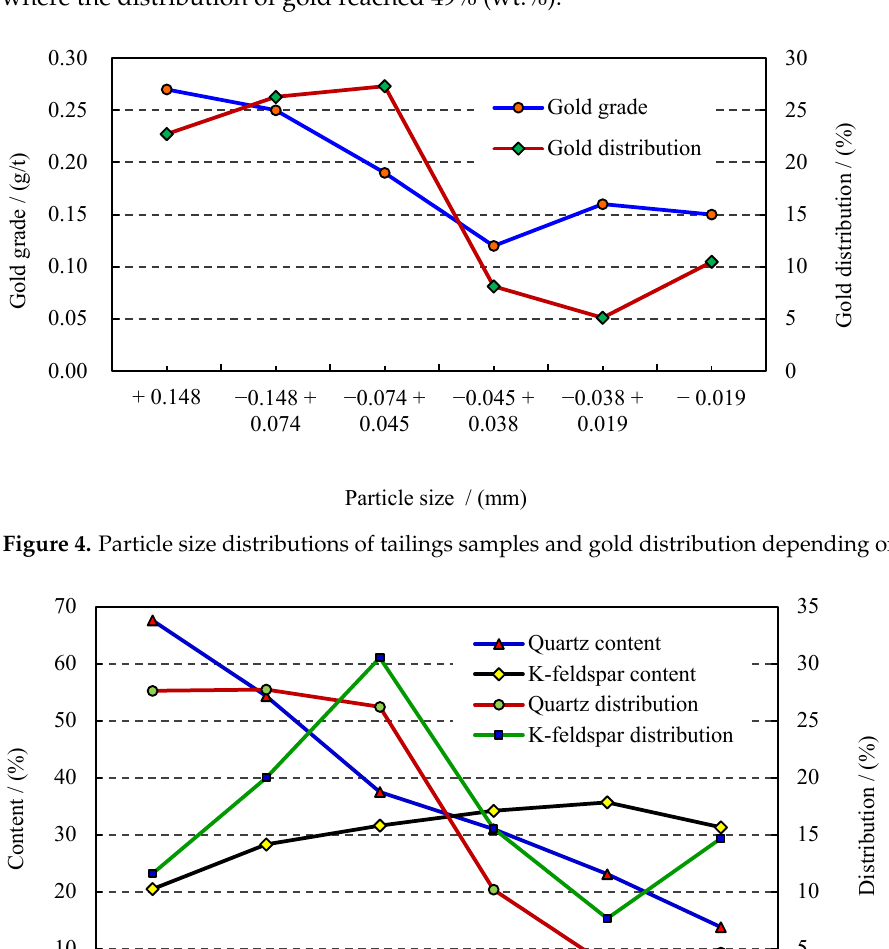
Figure 6. Liberation degree of quartz and K-feldspar in samples with different particle sizes. 3.2. Desliming through Hydrocyclone Classification By analyzing the mineralogical properties of the samples and investigating the com- ponents of the gold tailings samples, we found that the main minerals in the samples with a particle size of − 0.037 mm were sericite, carbonate, and iron. Fine slime in the tailings affects the recovery of quartz and feldspar [34]; thus, the slime should be removed before- hand. Table 5 summarizes the results of the desliming procedure. The table shows that Au and SiO 2 were prominently enriched in the desilting process, indicating that the de- sliming procedure can not only avoid the adverse effect of the fine slime but can also be effective for the subsequent recovery of quartz and gold.